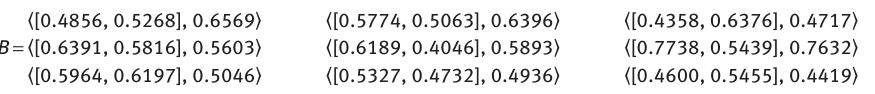
Table 3: The Normalized Cubic Decision Matrix.